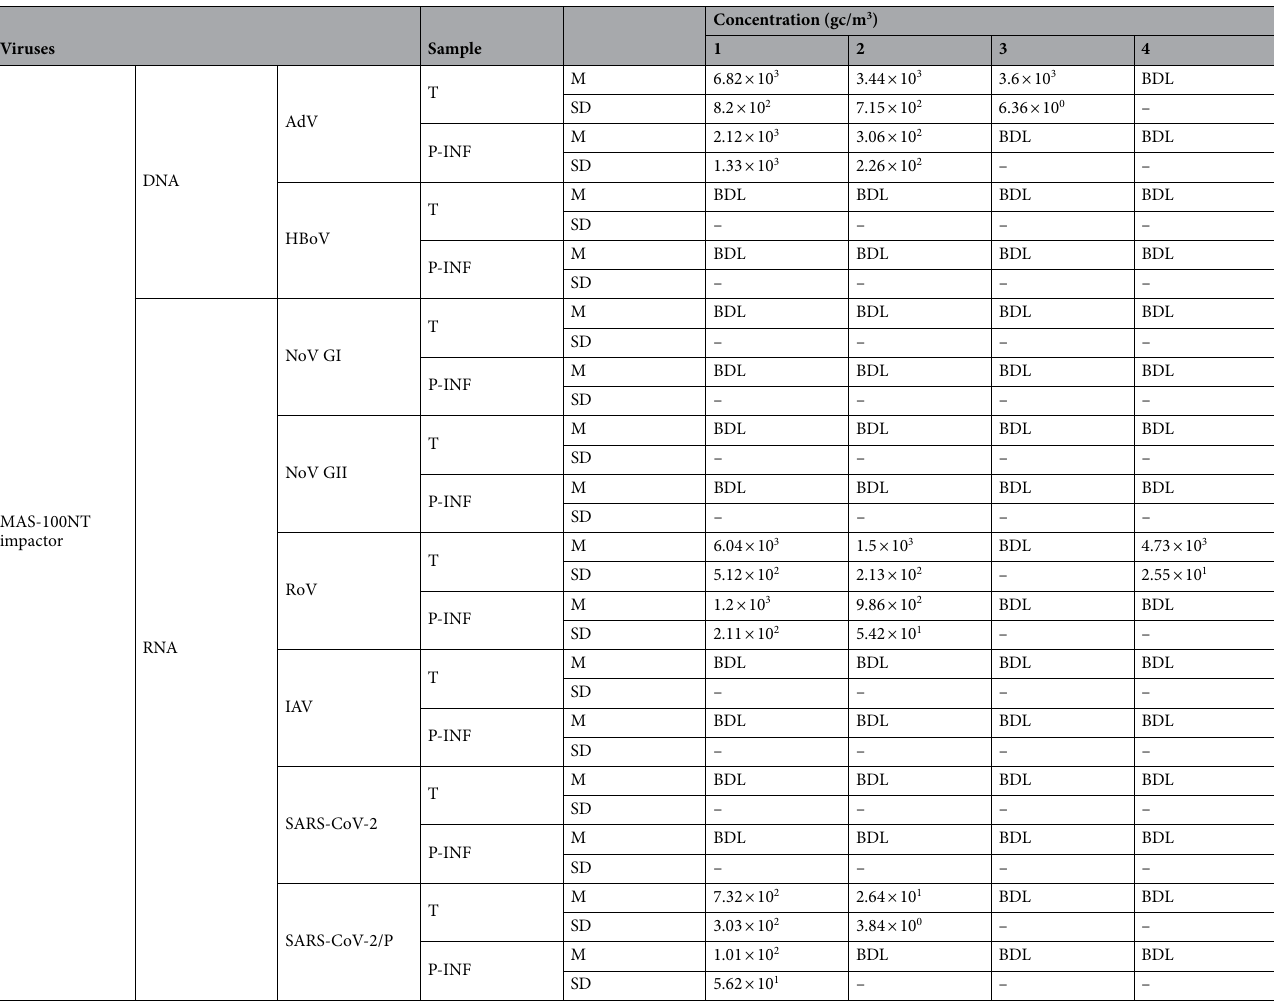
Table 4. The concentrations of DNA and RNA viruses (gc/m 3 ) in air samples collected using Coriolis μ impinger and MAS-100NT impactor at examined WWTP sampling sites. Notes: 1 – wastewater pumping section, 2 – screens section, 3 – grit chamber section, 4 – dewatering/thickening sludge section, AdVs – adenoviruses, HBoV – human bocavirus, NoV GI – Norwalk virus genogroup I, NoV GII – Norwalk virus genogroup II, RoVs – rotaviruses, IAV – influenza A virus, SARS-CoV-2 – severe acute respiratory syndrome coronavirus 2, SARS-CoV-2/P – presumptive SARS-CoV-2 positive/other coronaviruses positive, T – total concentration of viruses, P-INF – concentration of potentially infectious viruses, M – arithmetic mean value, SD – standard deviation, BDL – below detection limit.